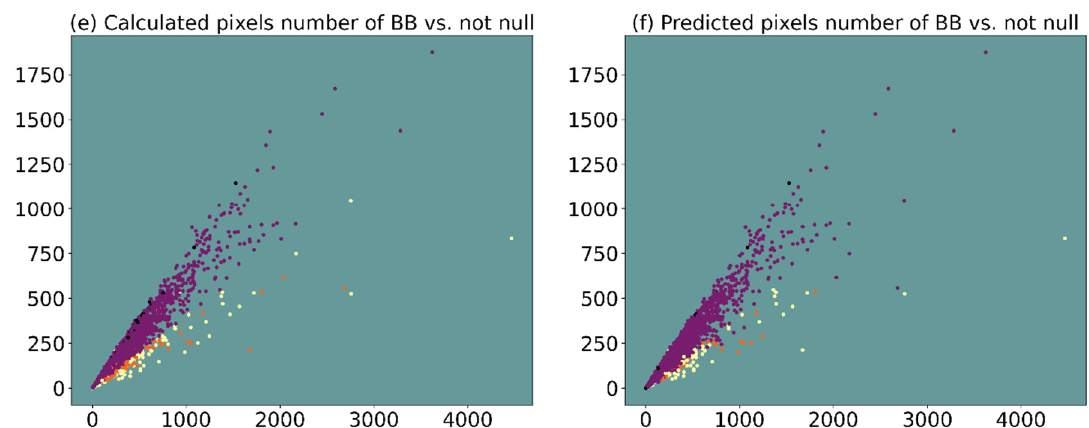
Figure 7. Plotted results of supervised classification. The “Calculated” column on the left ( a , c , e ) refers to data from a human expert, while the “Predicted” column ( b , d , f ) refers to values from K-NN algorithm. K-NN results plotted data were obtained using a training dataset at 50%.